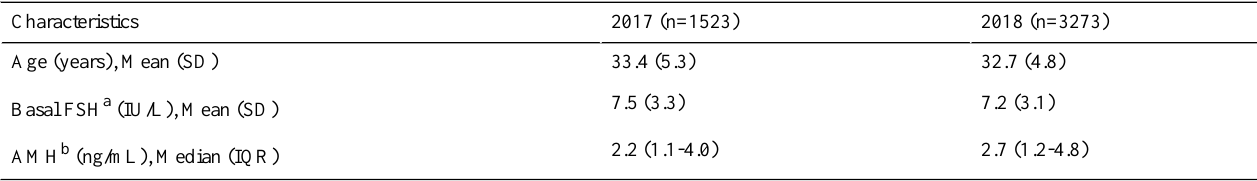
Table 1. Basic characteristics of treatment cycles.